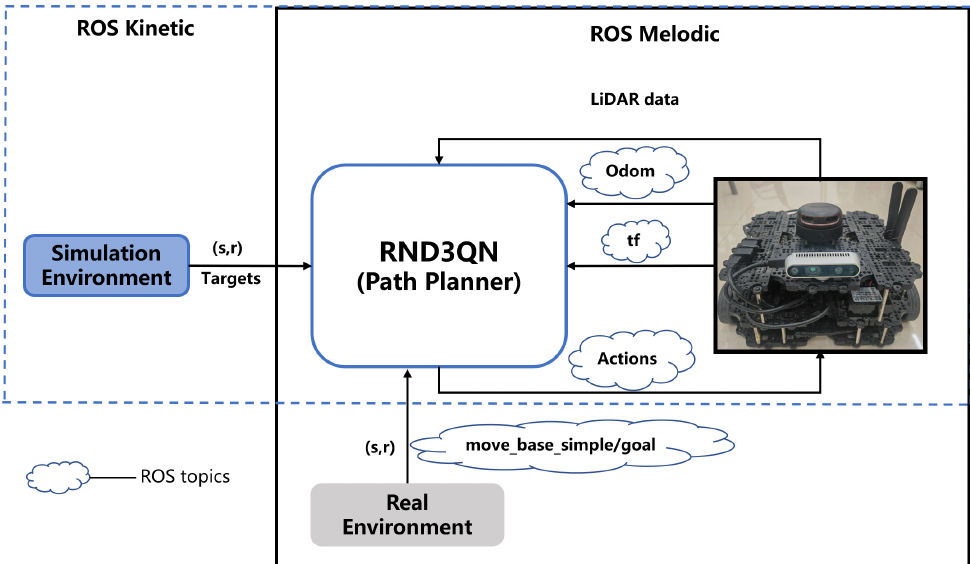
Figure 2. Training framework diagram for experiments based on ROS framework in simulated and real environment under different maps, respectively. The above figure depicts the planning process of the robot in the ROS framework. Firstly, the robot collects the environment data through sensors, after that the data is analyzed and passed to the agent (RND3QN), and finally the agent outputs the corresponding action instructions to be passed to the robot for